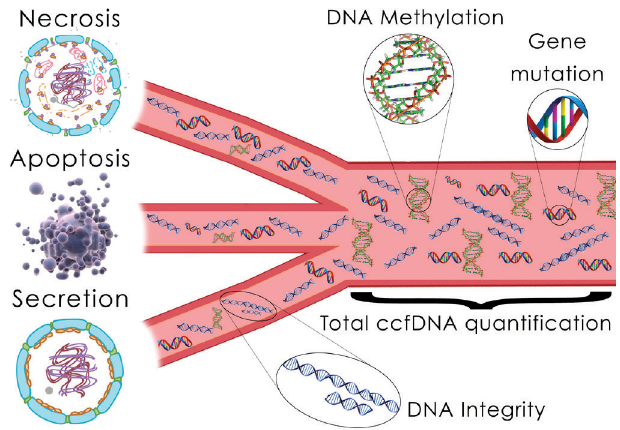
FIGURE 1 - Schematic mechanisms of release and ccfDNA